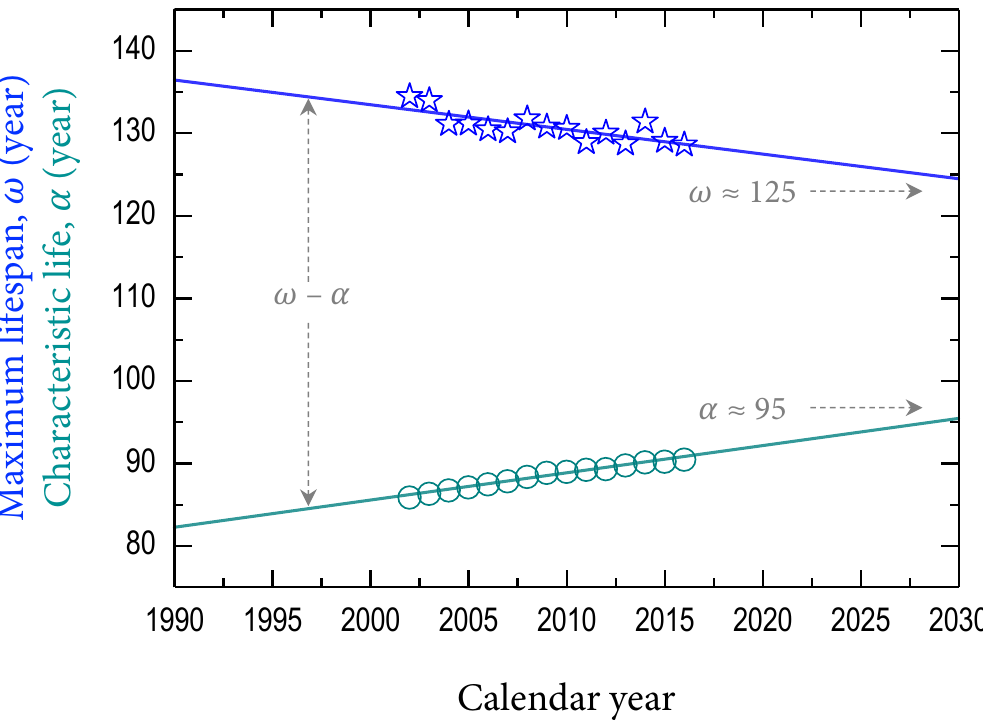
Figure 4. Estimation of the maximum lifespan and the characteristic life for Korean female (data from the Korean Statistical Information Service, http://kosis.kr/eng). The maximum lifespan gradually decreases at a constant rate of ∼ 2.99 years per decade and the characteristic life gradually increases at a constant rate of ∼ 3.30 years per